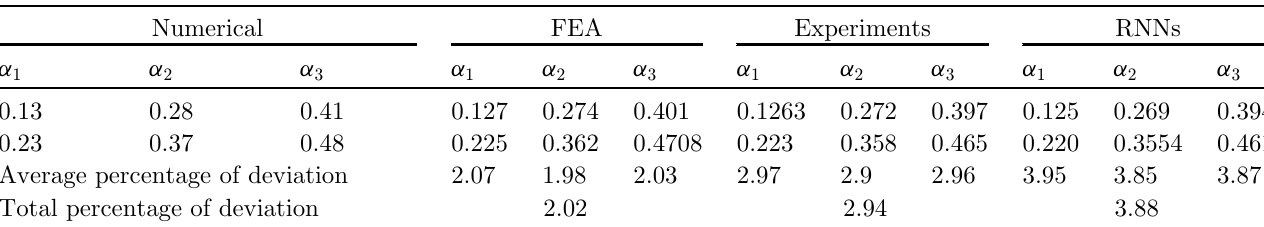
Table 4. Comparison of results for relative crack depth ( a ) with various methods.